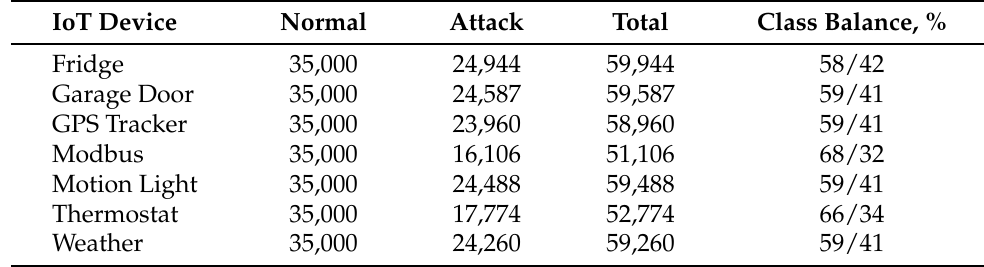
Table 1. The statistics on the TON_IoT dataset class balance by